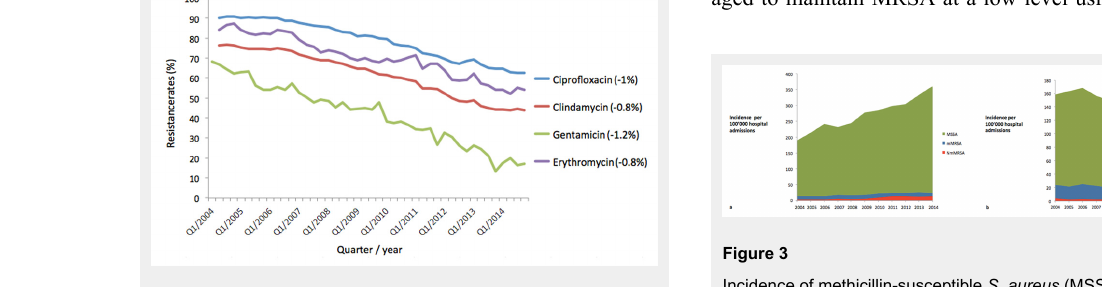
confirmed the same risk factors for MRSA (French and